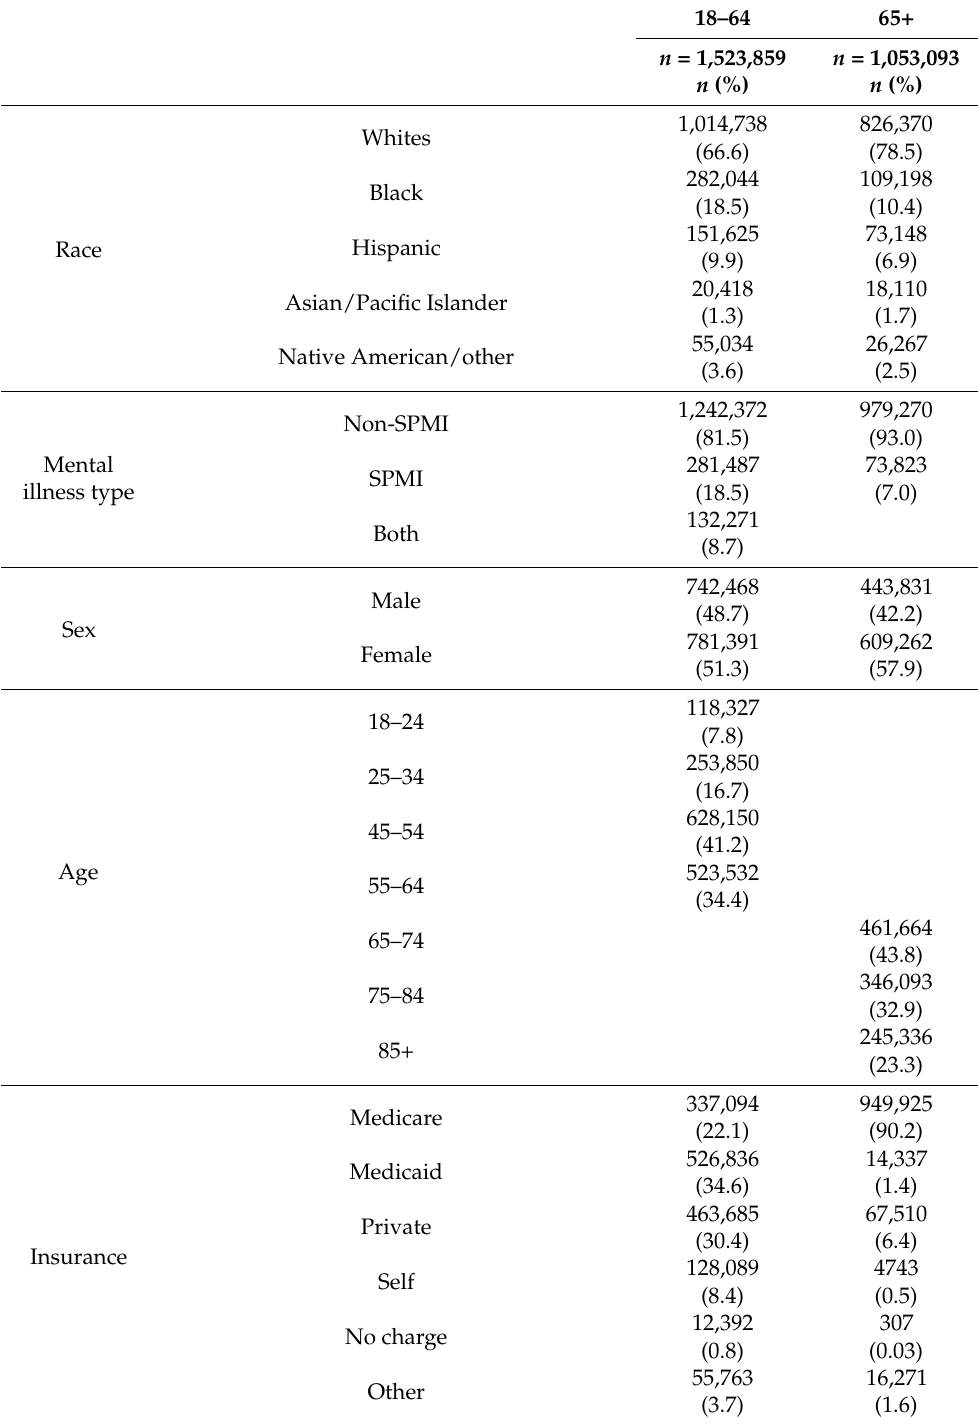
Table 1. Summary of Patient and Hospital Characteristics by Age Cohort: 18–64 and